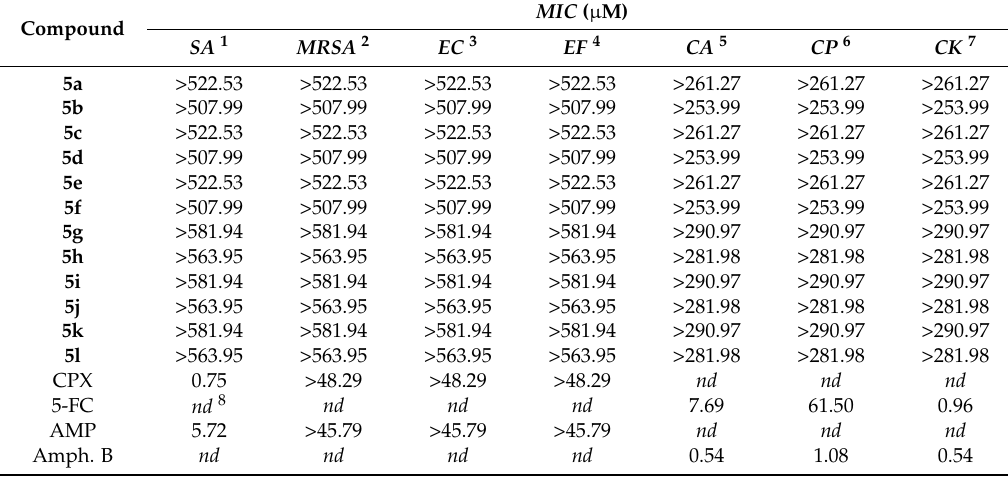
Table 5. The efficiency in vitro ( MIC ) of the compounds 5a – l and the reference drugs ciprofloxacin (CPX), 5-flucytosine (5-FC), ampicillin (AMP) and amphotericin B (Amph. B), respectively, against chosen Gram-positive and Gram-negative bacterial strains and the